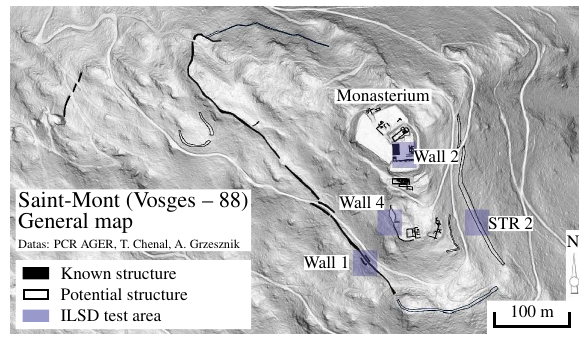
Figure 6. Archaeological prospections on St